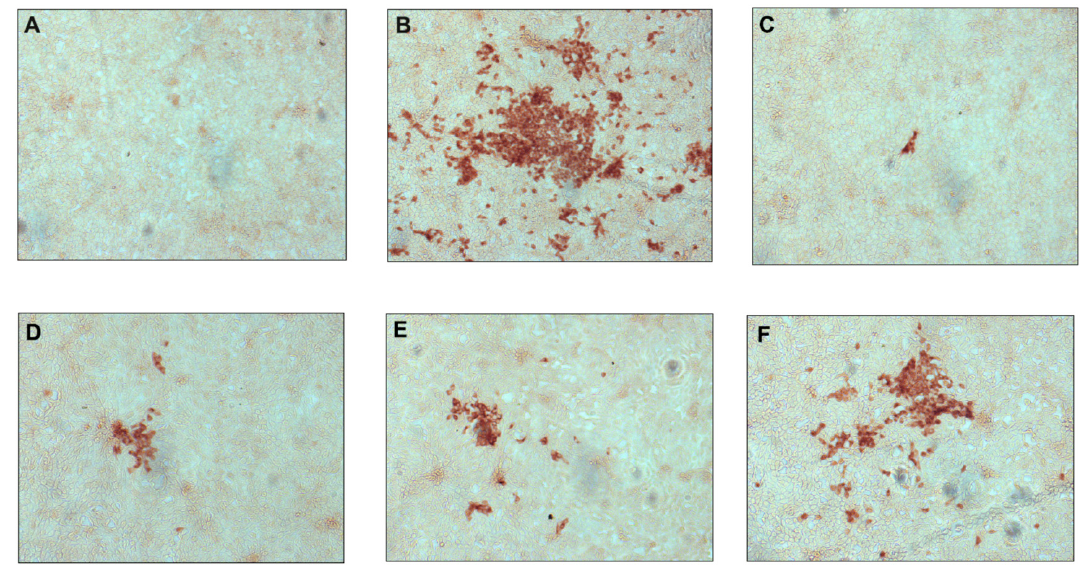
Figure 1. Effect of compound 9 on pseudo-plaque formation in classical swine fever virus (CSFV)-infected swine kidney (SK6) cells. SK6 cells were mock infected ( A ) or infected with CSFV at a MOI of 0.001 ( B – F ). At 2 h post infection, cells were treated with various concentrations of compound 9 (( C ) 16 µM, ( D ) 12 µM, ( E ) 8 µM, and ( F ) 4 µM)) or left untreated (positive control ( B )). Two days post infection, cells were fixed, and virus pseudo-plaques were detected by immunostaining with rabbit polyclonal anti-E rns serum. Table 2. Inhibitory effects of all synthesized compounds on classical swine fever virus (CSFV)